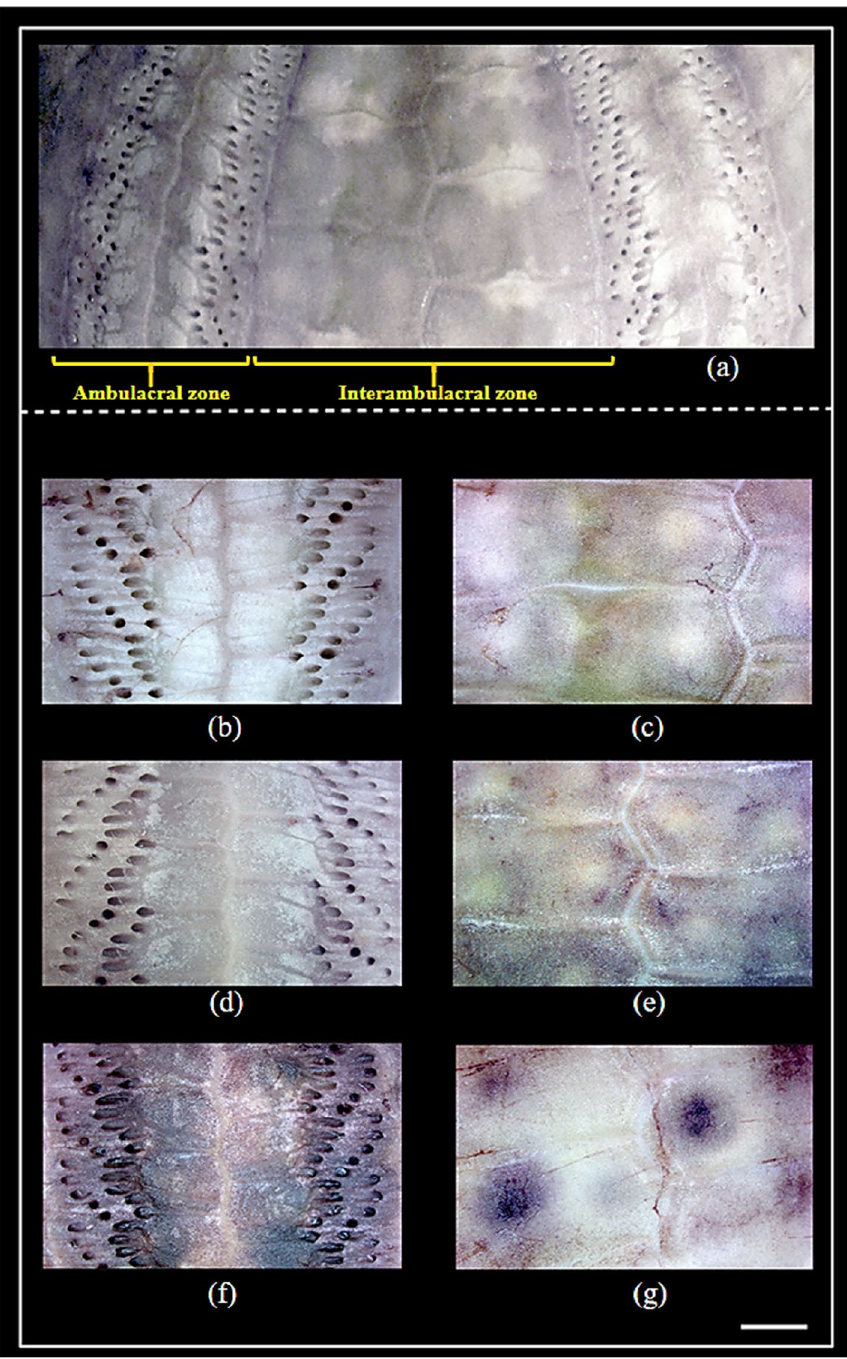
Figure 3. Internal view of green sea urchins ( S. droebachiensis ) hard body shells (test) after the in vivo bacterial challenge experiment with V. echinoideorum at ± 6–8 °C. ( a ) Healthy interior of the ambulacral and interambulacral test zone. ( b ) and ( c ) represents the intact ambulacral and interambulacral area of a healthy sea urchins. Here, ( d ) and ( e ) depicts the artificially wounded sea urchins without exposure to bacteria. No signs of calcareous skeleton, blackish patches, swelling of tube feet pores and darkened perforations are seen, whereas ( f ) and ( g ) represents the artificially wounded, bacterial exposed sea urchins with signs of skeletal damage. Scale bar 2